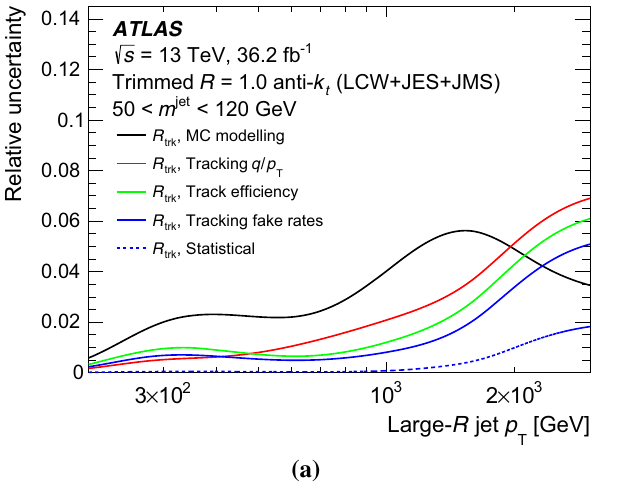
Fig. 31 BreakdownofthecombinedJMSuncertaintyshowninFig.30 as a function of jet transverse momentum p T for the jet mass bin 50– 120 GeV. Contributions are shown for each of the nuisance parameters of the a R trk and b forward-folding methods. The vertical axis reflects